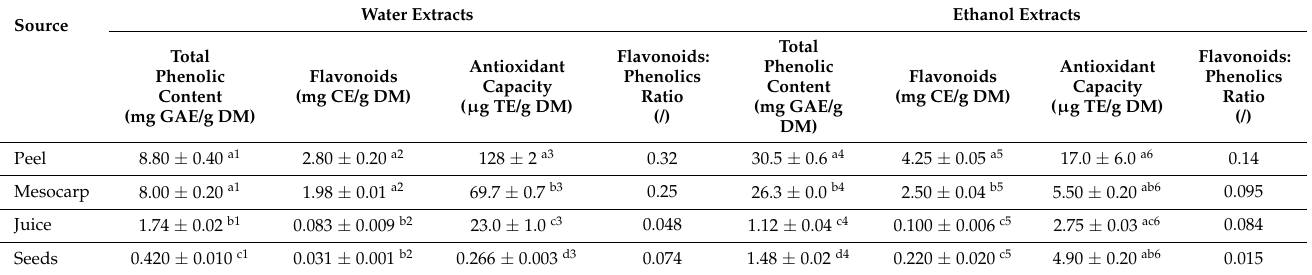
Table 3. Polyphenol group profile and antioxidant capacity of water and 70% ethanol extracts of pomegranate fruit